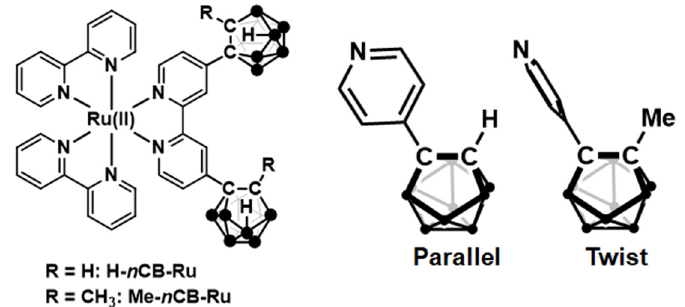
Figure 1. Chemical structures and molecular conformations of the ruthenium complexes used in this study.